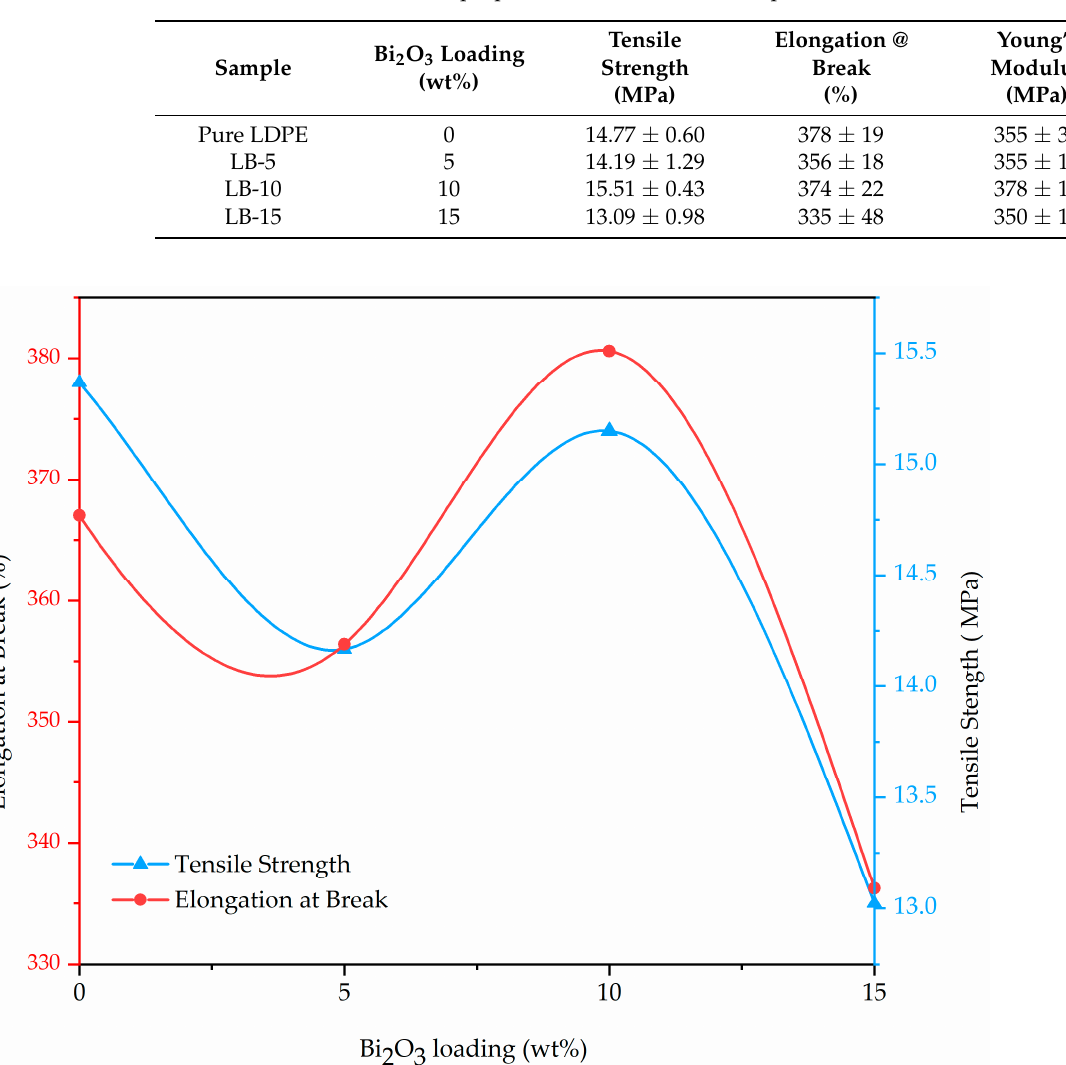
Table 4. Results of mechanical properties of LDPE and its composites.